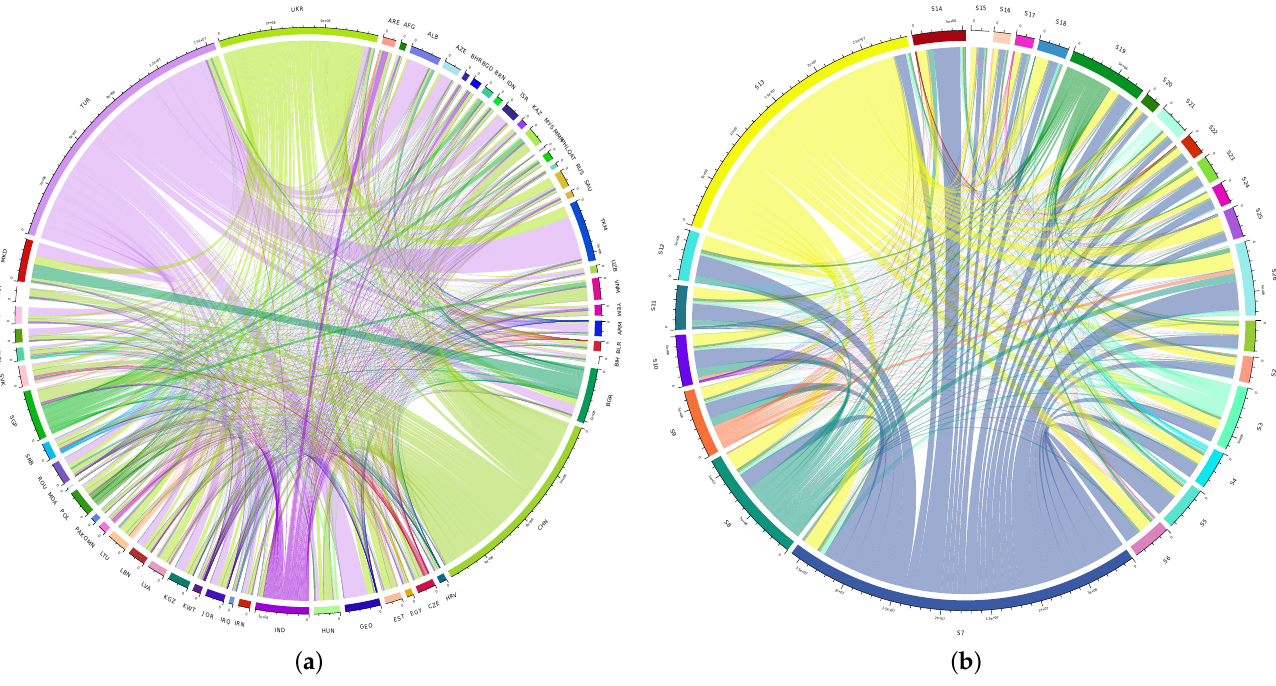
Figure 3. Embodied natural gas scarcity risk flows in the EGSR transmission network in 2015. ( a ) International flow. ( b ) Inter-sectoral